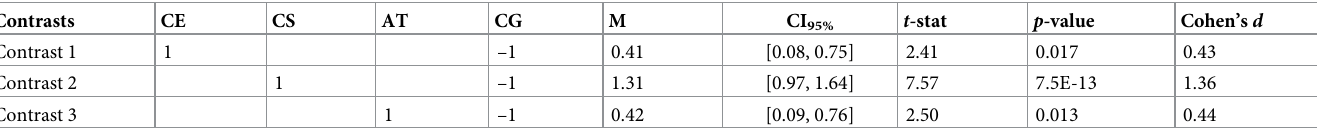
Table 2. Planned contrasts with the corresponding statistics for the debiasing treatment groups on the differences o 1 –o 4 . Contrasts